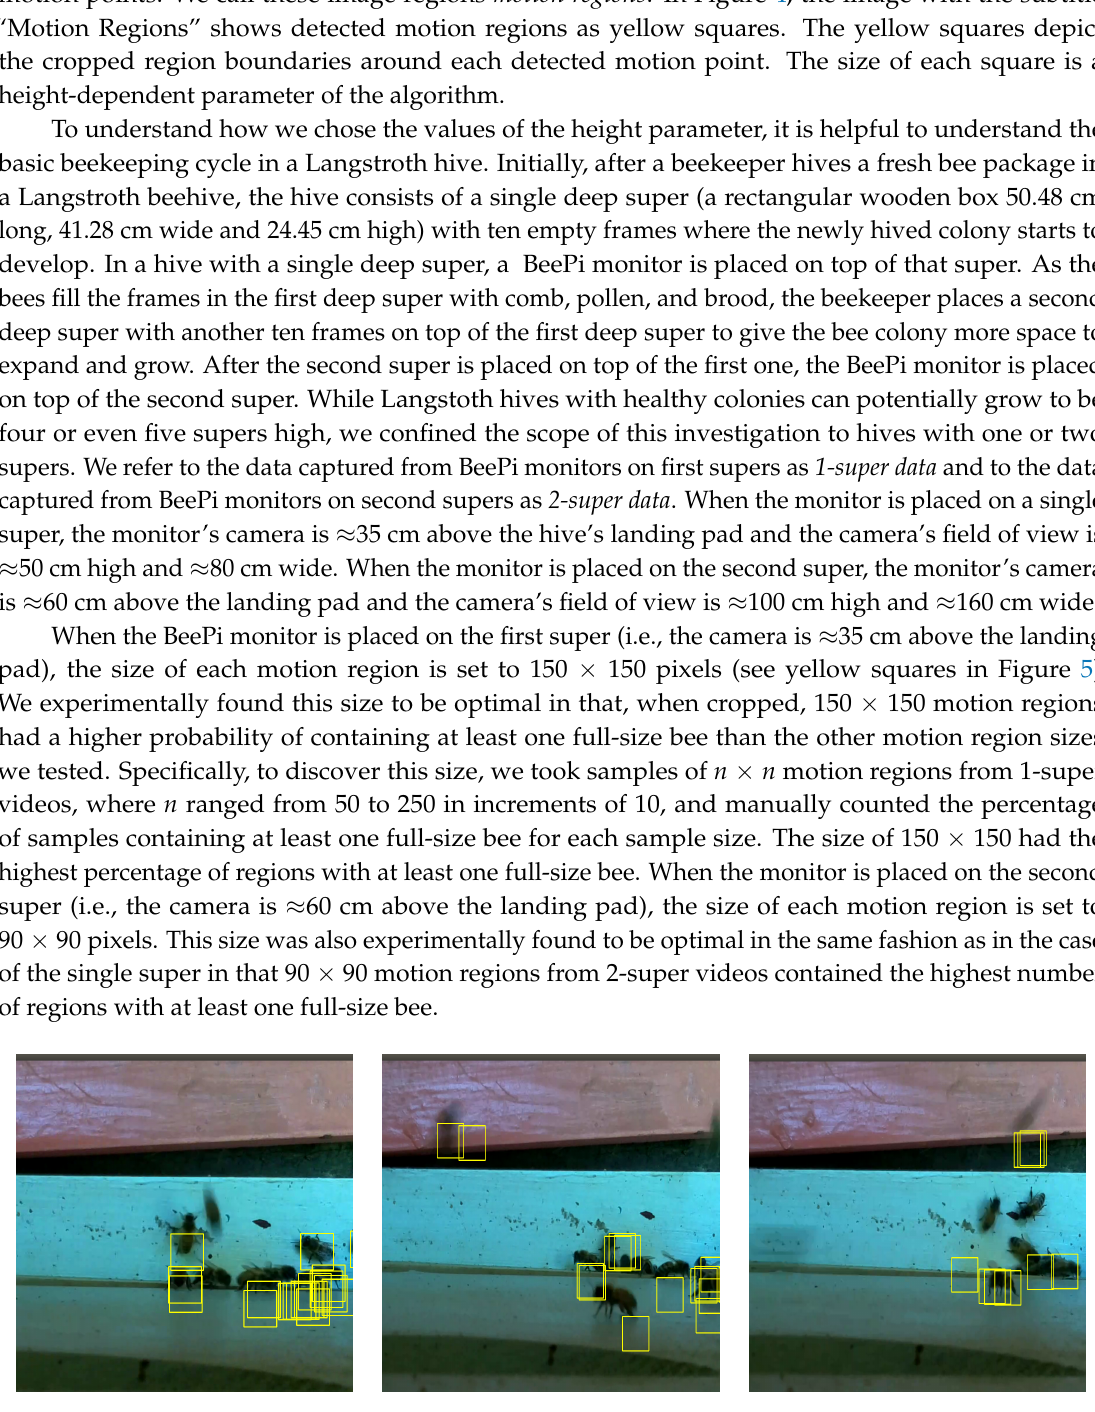
Figure 5. Three sample frames of the landing pad of a Langstroth beehive captured from a BeePi monitor’s camera mounted on top of the first deep super. The yellow squares mark 150 × 150 regions with detected motion. The performance videos in the Supplementary Materials show how our system detects bee motions in real